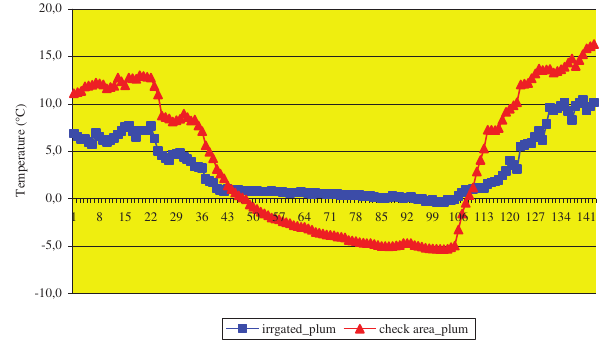
Figure 9 – Temperatures as changing in the spraying experiment with 3 minute intervals (blue) related to the check area (red) at Pallag between April 9. 09.00 and 10. 09.00, 2012.